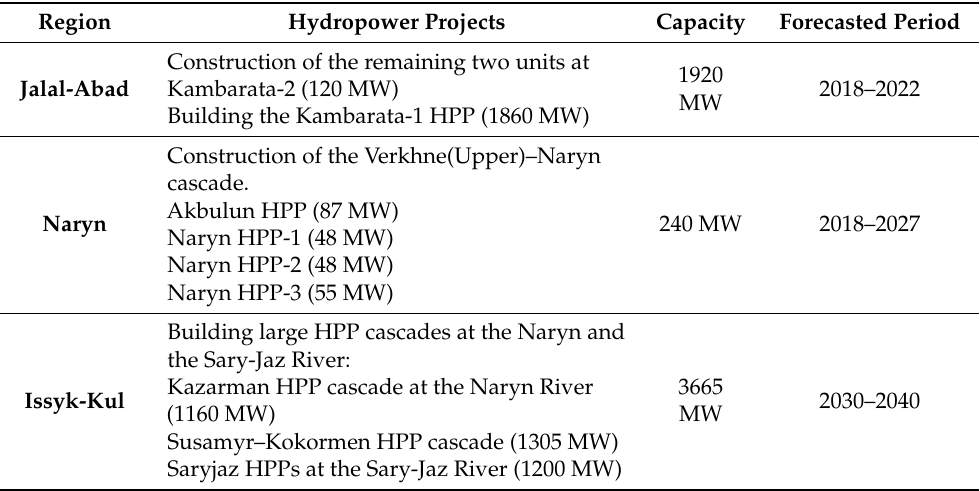
Table 1. Selected planned Hydropower power plant (HPP) in Kyrgyzstan (data according to [17]). Region Hydropower Projects Capacity Forecasted Period Construction of the remaining two units Jalal-Abad